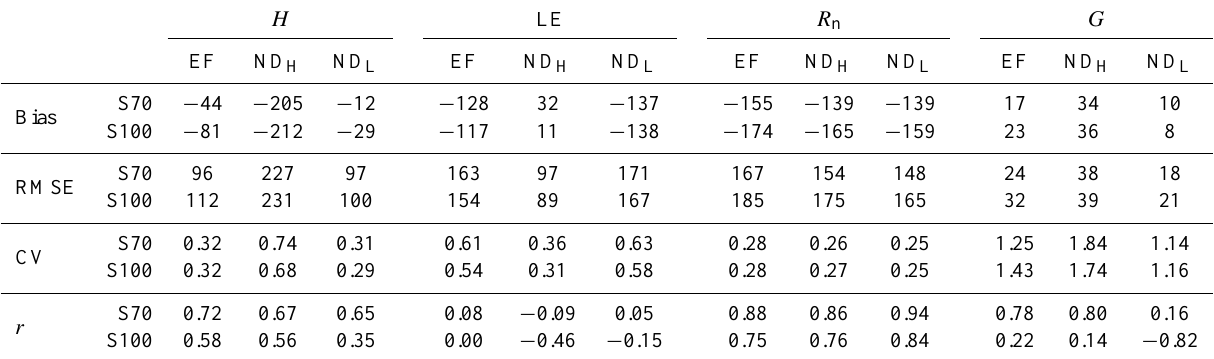
Table 5. Statistical comparison of modelled vs. observed fluxes at GLU with the meteorological inputs provided by the ERA-Interim data set. Statistics are shown for the EF approach for estimating constant ratio used during the disaggregation procedure and for the non-disaggregated high, ND H , and low, ND L , resolution fluxes. Modelled fluxes are instantaneous at the time of satellite overpass and observed fluxes are 30min averaged EC measurements. The statistical parameters used are bias (modelled–measured), root mean square error (RMSE), coefficient of variation (CV – RMSE divided by mean of observed values), and correlation ( r ). Bias and RMSE are in Wm − 2 , the other parameters are unitless. H LE R n